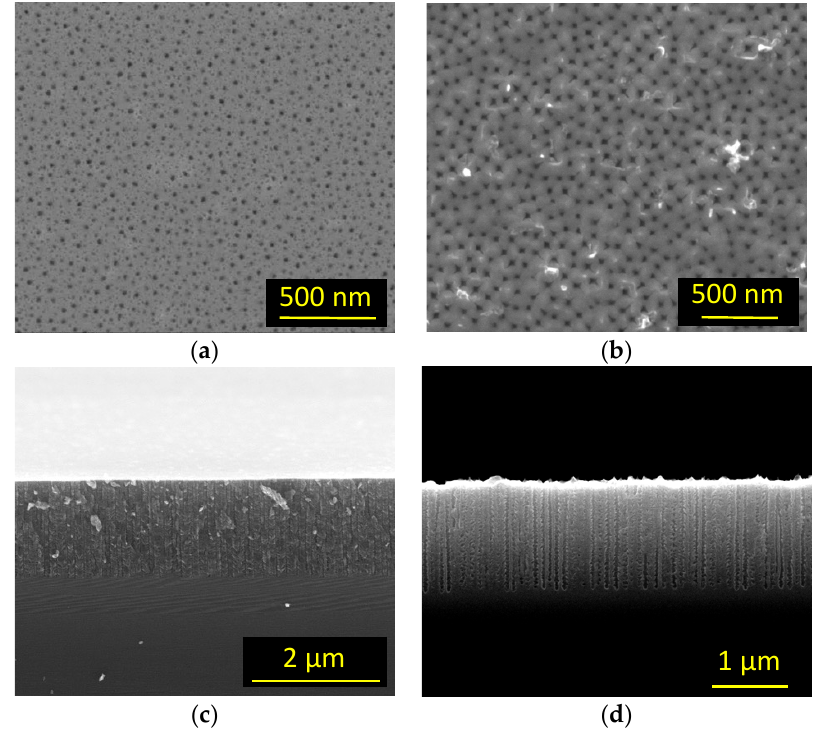
Figure 4. SEM images of typical PSi samples used for pore density measurements. ( a , b ): Top view of a standard PSi sample and of a PSi sample fabricated after ENL, respectively. ( c , d ): Cross-sections of the samples shown in ( a , b ), respectively. In the pore density measurements, several image sizes have been used for each sample to avoid possible sample inhomogeneities.